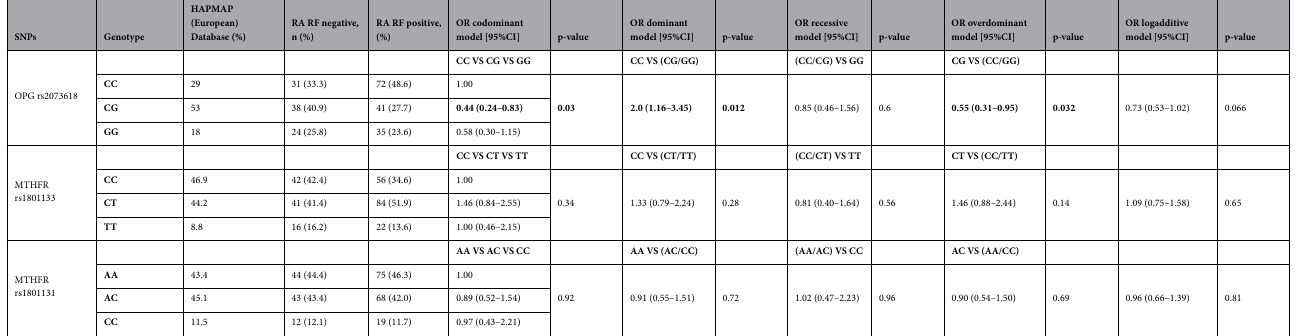
After RA patients were stratified according to anti-CCP status and adjustment for age and sex, genotype analysis revealed a statistically increased prevalence of the CC genotype of rs2073618 OPG SNP in anti-CCP positive RA patients compared to HC (Table 5) (OR [95% CI] 1.89 [1.18–3.03], p-value: 0.0077, in the dominant model). Moreover, anti-CCP positive RA group displayed decreased frequency of the CG genotype compared to HC [32.6% vs 45.7%, p-value: 0.018, in the overdominant model] (Table 5), as well as of the GG genotype com- pared to anti-CCP negative counterparts (19.9 vs 31.6, p-value: 0.04 in the recessive model, Table 6). Decreased frequency of the CG genotype in anti-CCP negative RA patients compared to HC [31.6% vs 45.7%, p-value: 0.013, in the overdominant model] was also found (Suppl. Table S4).